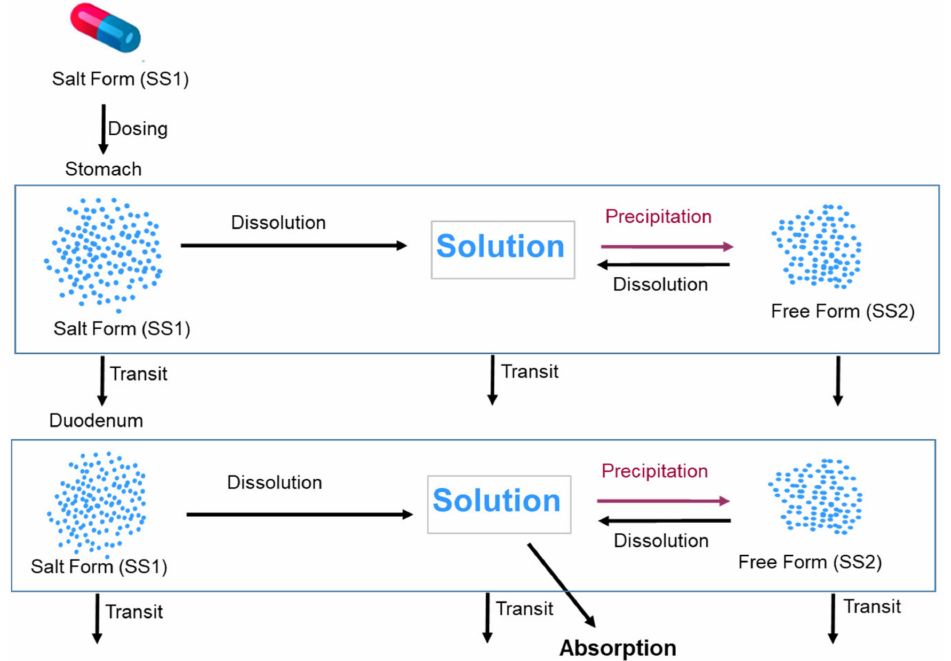
Figure 2. Modelling approach taken to predict the absorption of the salt form of the model compound utilizing the two Solid States model in the Simulator. The figure shows only stomach and duodenum compartments, similar processes occur in other segments of the GI